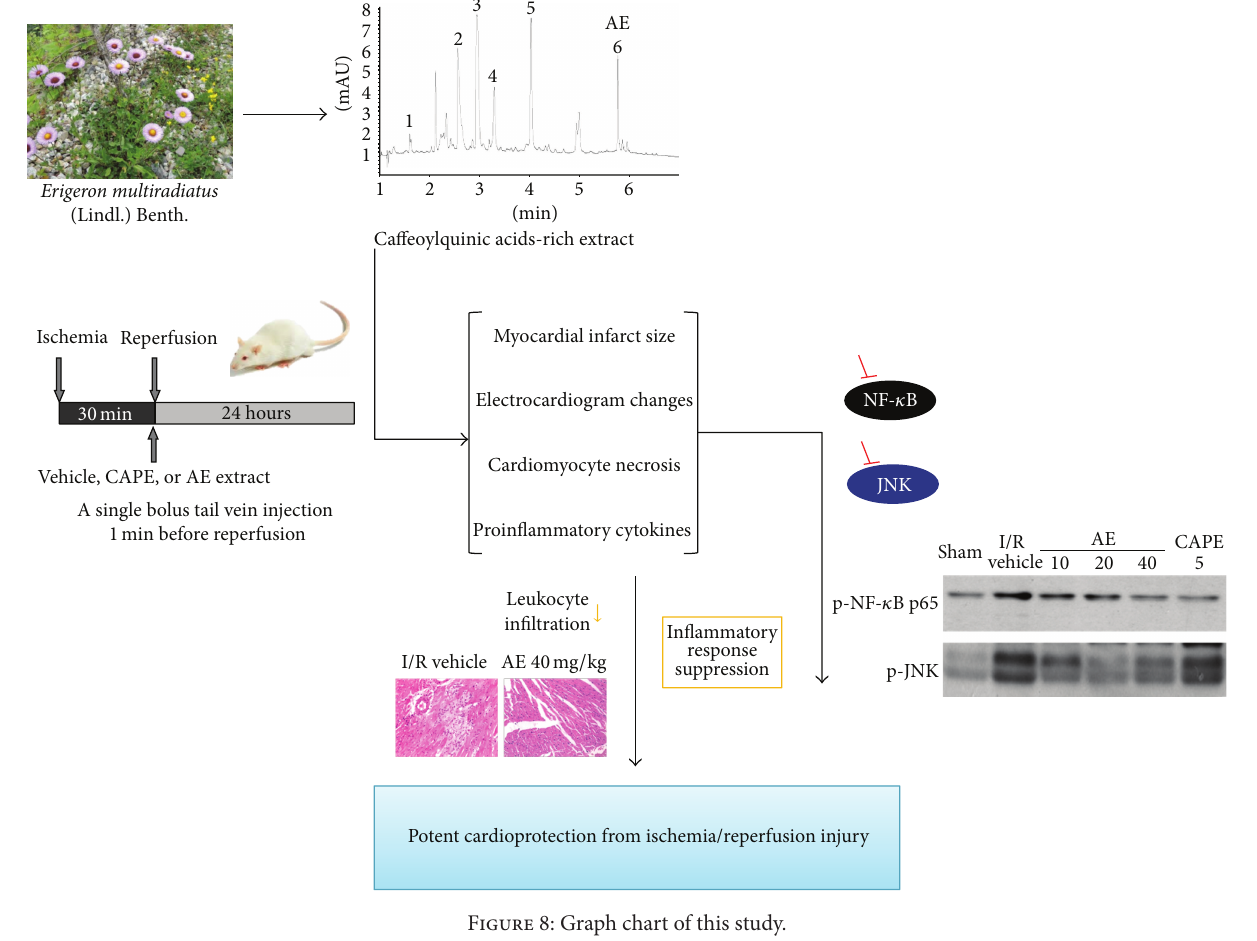
Figure 8: Graph chart of this